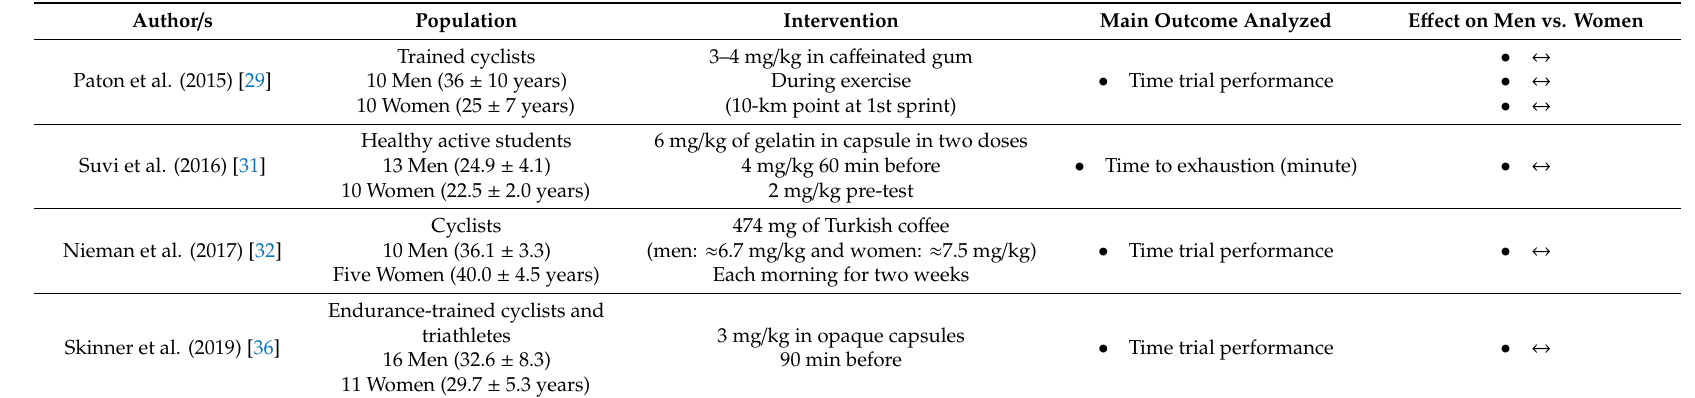
Table 1. Summary of studies included in the systematic review that investigated the e ff ect of ca ff eine ingestion between sexes on aerobic